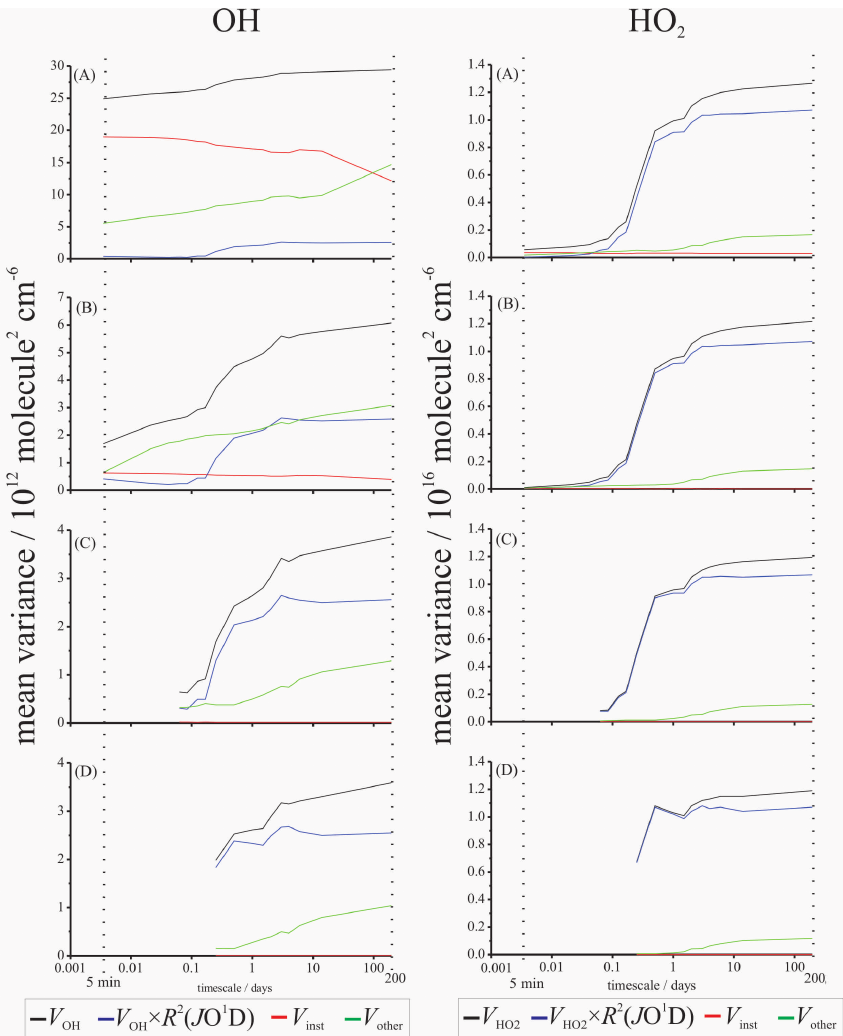
Fig. 11. The mean variances of 1 s (A) , 30 s (B) , 20 min (C) and one hour (D) averaged [OH] (left-hand panels) and [HO 2 ] (right-hand panels) during SOS as a function of binsize; the different coloured lines correspond to the total variance (black), the variance due to instrument noise (red), the variance due to J (O 1 D)-dependence (blue) and the contribution from other sources (green). The dashed vertical black line represents the timescale of individual measurement runs (i.e. five